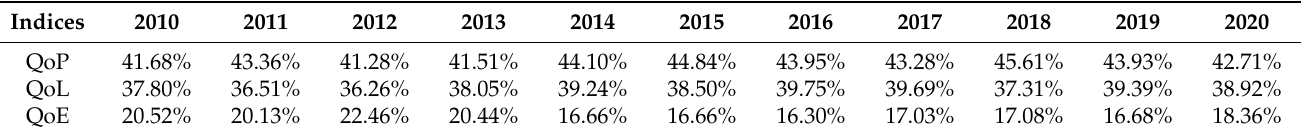
Figure 2. Time series changes in the city’s “production, living and ecological” environmental quality scores, 2010–2020. Table 4. Scores for the three tiers of indicators